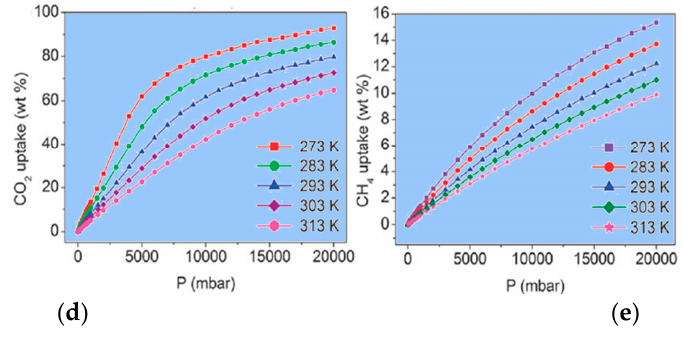
Figure 10. ( a ) 3D metal-organic framework of 50 . ( b – e ) Adsorption isotherms of 50 for ( b ) N 2 , ( c ) H 2 and D 2 (inset), ( d ) CO 2 , and ( e ) CH 4 . Adapted from [61].